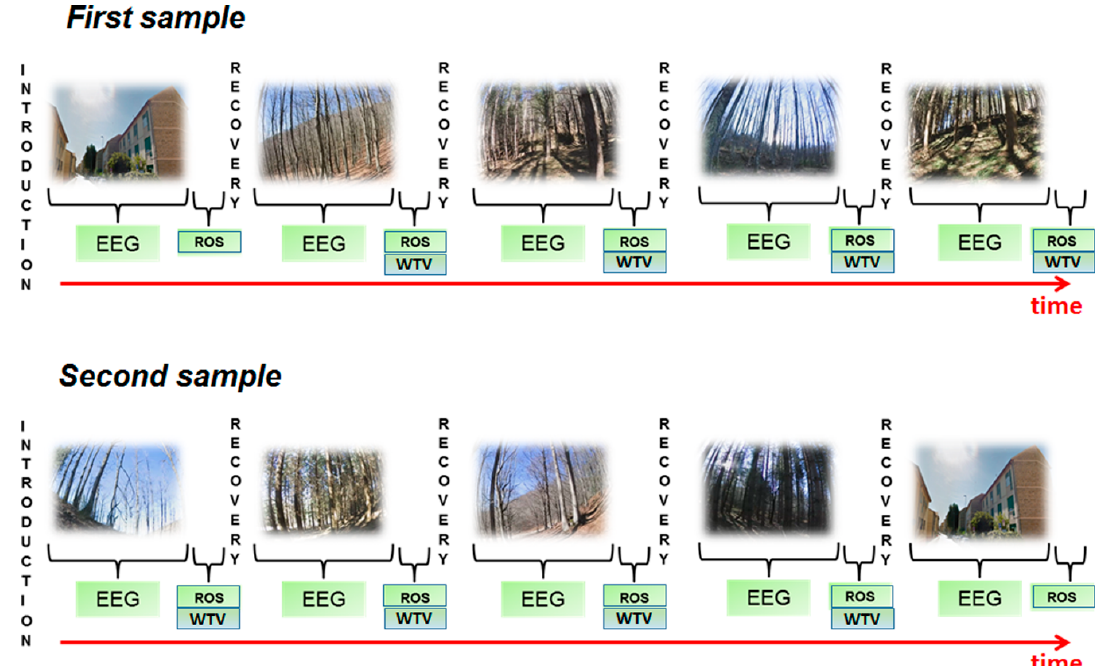
Figure 2. Sequence of stimuli presentation, EEG recording and interviews for first (T1) and second (T2) samples.